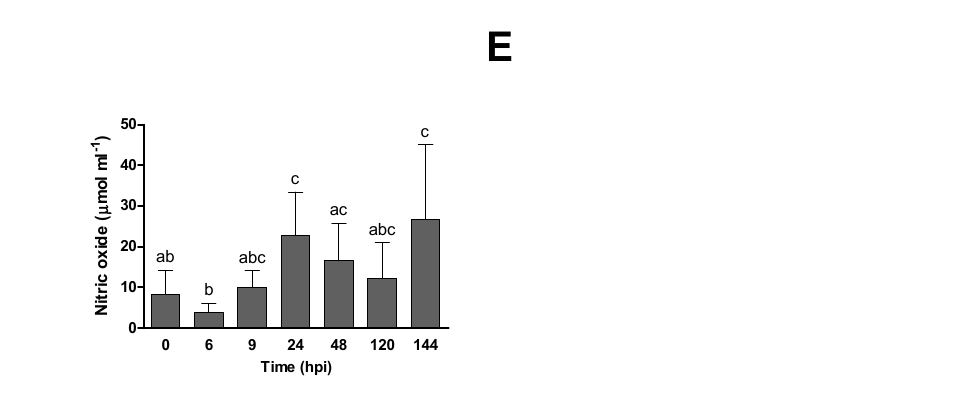
F Figure 3. Cont